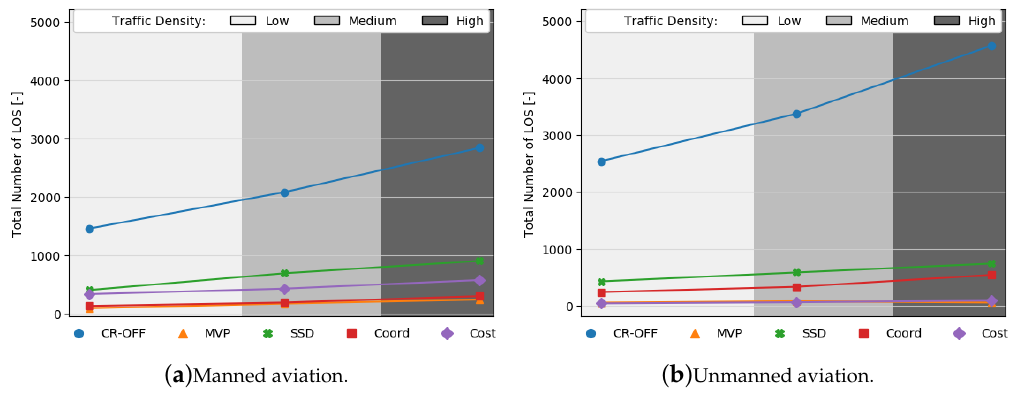
Figure 13. Total number of losses of separation per CD&R